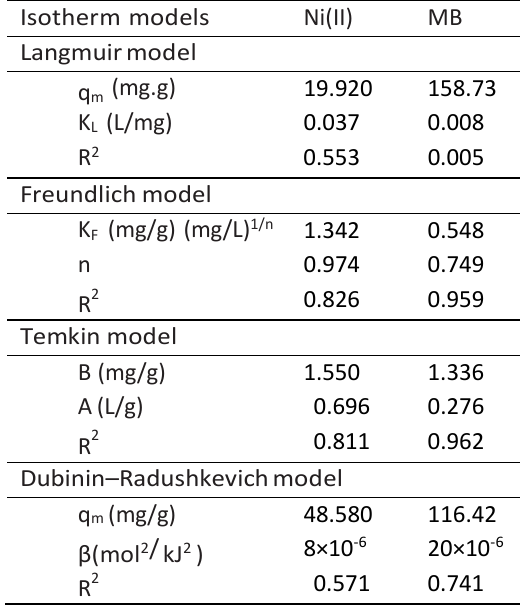
A comparison of the Langmuir, Freundlich, Temkin and Dubinin- Radushkevich isotherm constants for the adsorption of Ni (II) ions and MB into natural